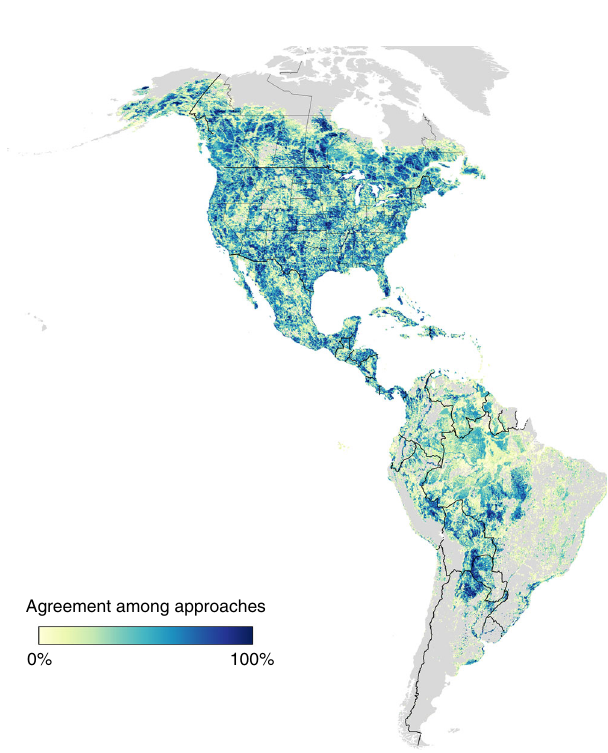
Fig. 3 Range of agreement between the eight scenarios investigated. Darker blue indicates that most or all scenarios selected speci fi c areas across the Western Hemisphere, and lighter yellow indicates areas of high scenario speci fi city. Scenario types considered: (i) summing scenarios for each species in each week of the year vs. optimizing over all weeks and species in a yearly approach, (ii) including vs. ignoring spatial clustering of species abundance, and (iii) incorporating vs. avoiding human-dominated landscapes in